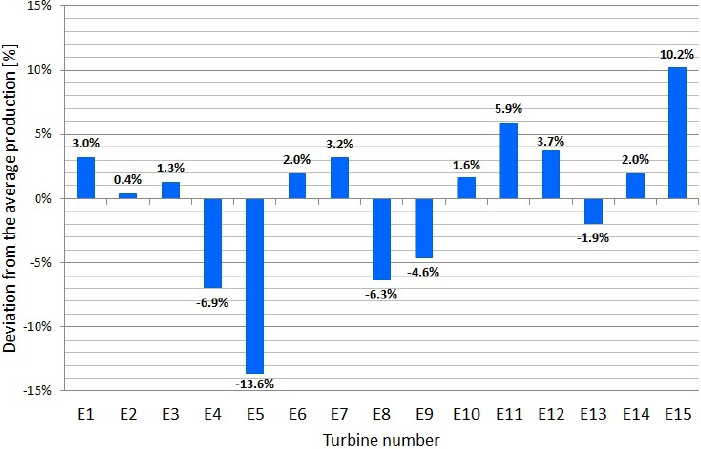
Figure 4. The annual deviation from the average electricity production for the respective turbines E1–E15, wind power plant